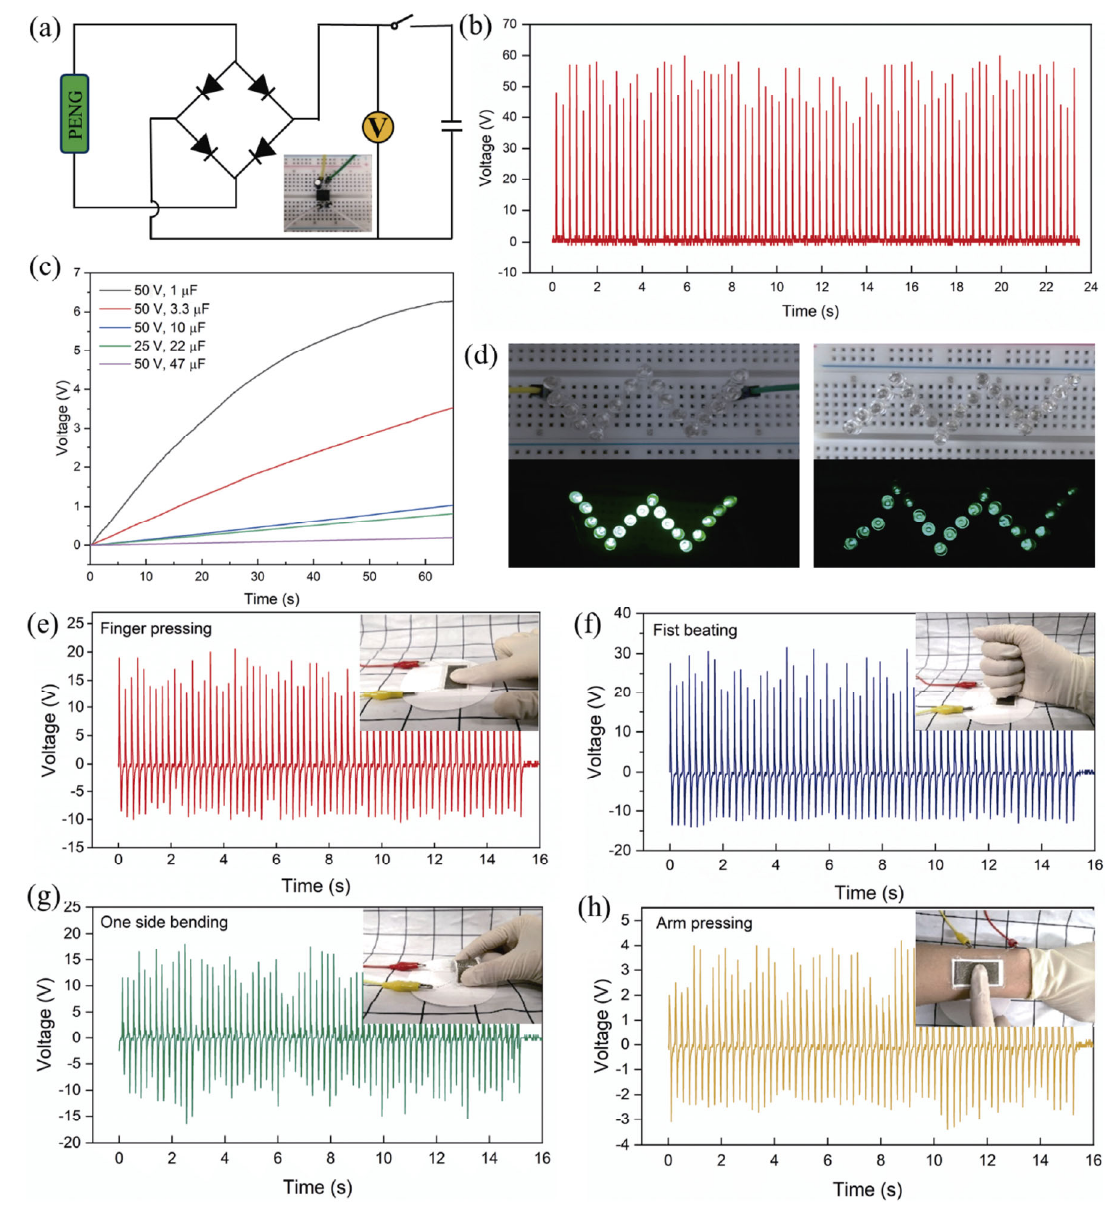
Fig. 8 (a) Equivalent circuit diagram of the charging commercial capacitor with a charging system inset; (b) rectified voltages of f-P 0.10 fiber-based PENG with a thickness of ~220 μ m; (c) charging voltages of various capacitors; (d) green LEDs lit by the rectified voltages of the PENG, output voltages from f-P 0.00 fiber-based PENG under (e) finger pressing, (f) fist beating, (g) one side bending, and (h) pressing on the